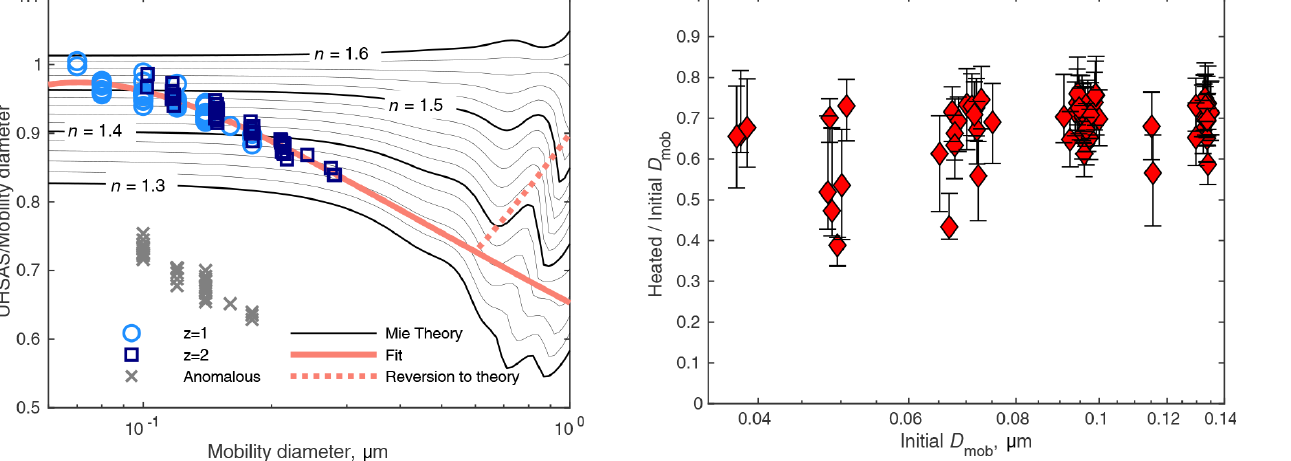
Figure 8. The ratio of apparent to actual diameter measured in the DMA → UHSAS tests superimposed on a contour plot of Mie cal- culations of refractive index and apparent particle diameter. The la- bels show real refractive indices; absorption is assumed to be 0. The fit line is from Fig. 7, and the dashed line is an arbitrary modification meant to reflect a transition from BB particles in the accumulation mode to sea-salt-like particles at 1µm. Symbols represent the same data as in Fig. 7.